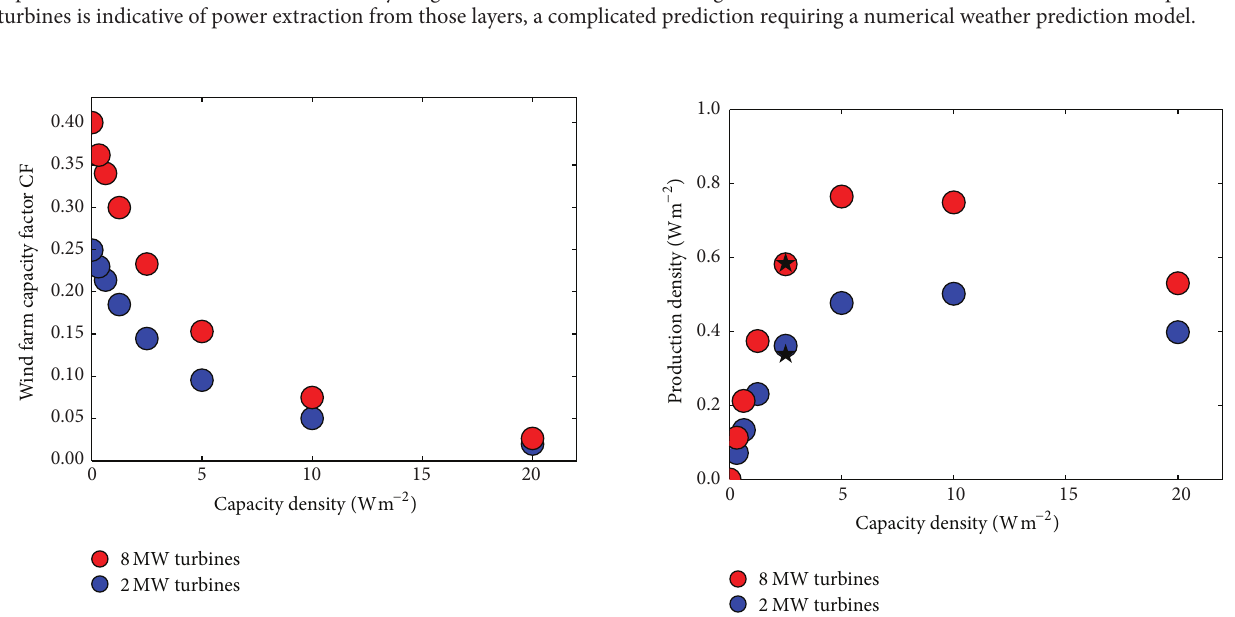
deployments. The two points marked with a star are for simulations repeated using twice the number of grid points within the depth of the boundary layer, as compared with the standard resolution. The simulations with standard resolution are indicated with a circle. The vertical positions of the grid points in the standard resolution are listed in Figure